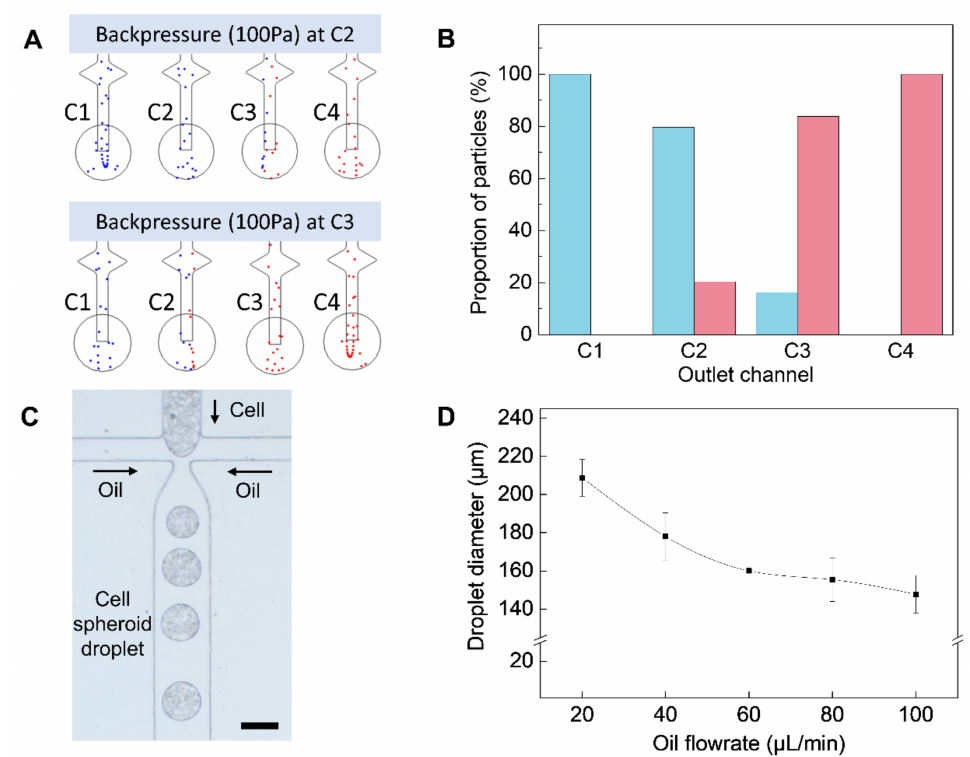
Figure 2. ( A ) COMSOL simulation of particle analysis for cell gradient. ( B ) Graph showing blue and red fraction of particles from each outlet. ( C ) Microscope image of encapsulated cell droplets generated using the microfluidic gradient droplet system. ( D ) Graph of cell droplet diameter with respect to oil flow rate at constant aqueous